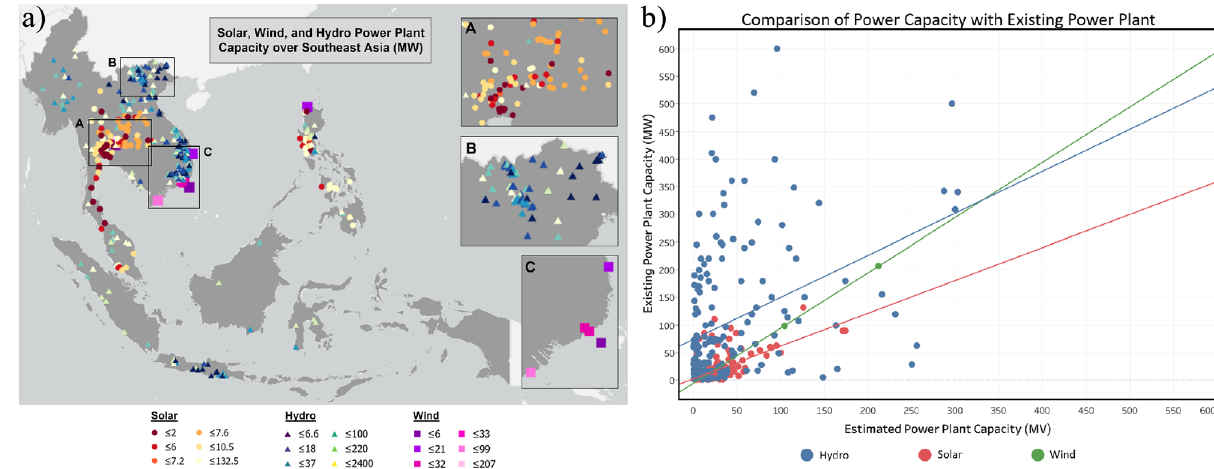
Figure 8. ( a ) The distribution of solar, wind, and hydropower plants in Southeast Asia and their generating capacity. ( b ) Comparison of the estimated power capacity of solar, wind, and hydropower plants with the existing power plants described in the Global Power Plant Database 36